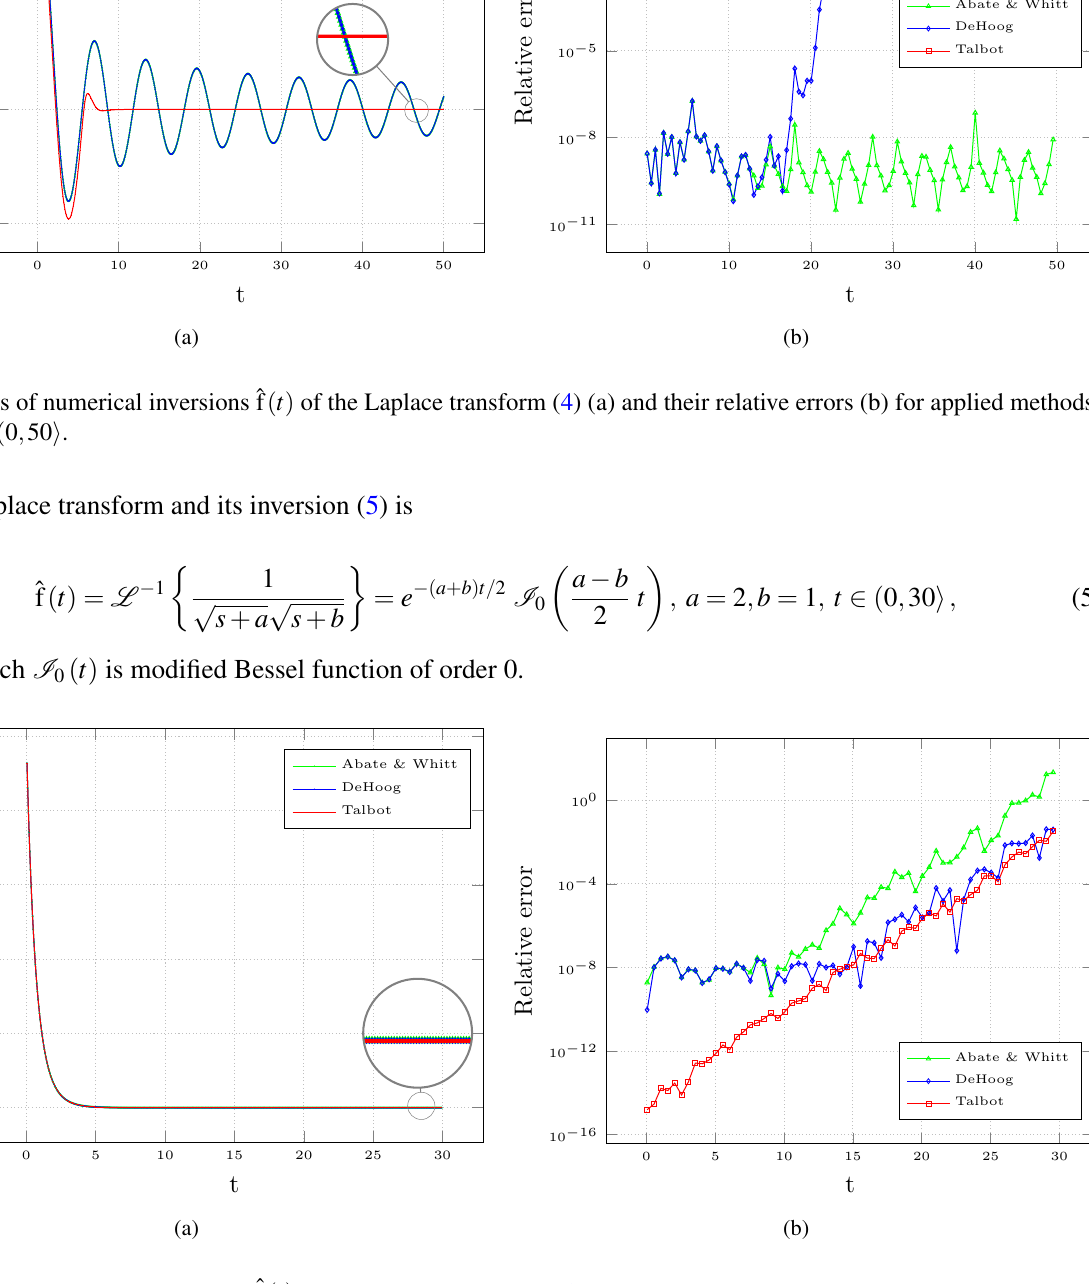
Fig. 5 Plots of numerical inversions ˆ f ( t ) of the Laplace transform (5) (a) and their relative errors (b) for applied methods in interval ( 0 , 30 (cid:105)